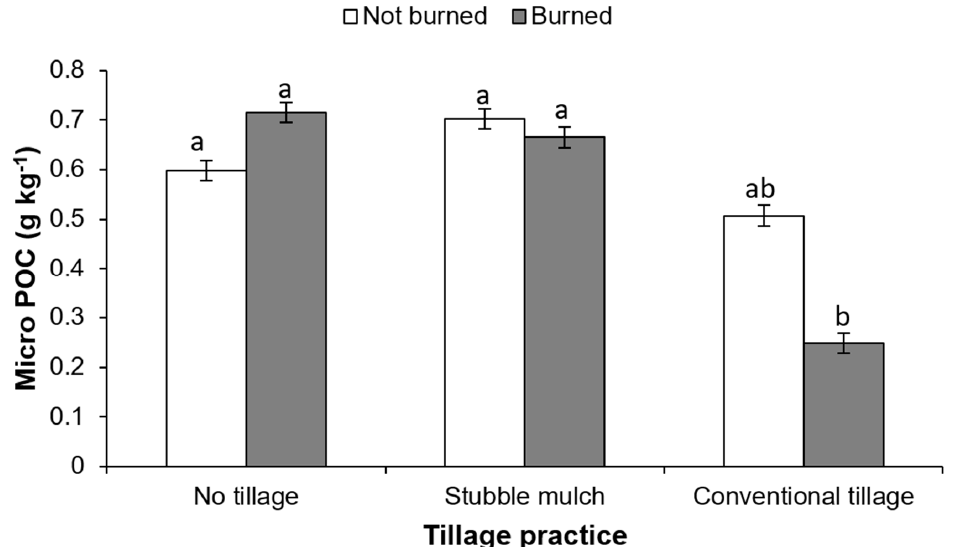
Figure 3. The interaction effect of tillage × straw management on micro POC (g kg − 1 ) in the 0–50 mm soil layer. Error bars represent the standard errors of the mean and different letters (a,b) in the bars represent significant differences at p < 0.05 according to Tukey’s multiple comparison test.